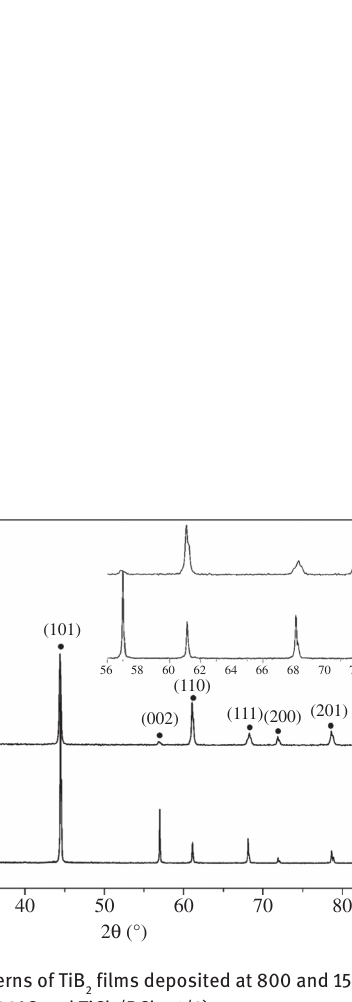
Figure 2: XRD patterns of TiB